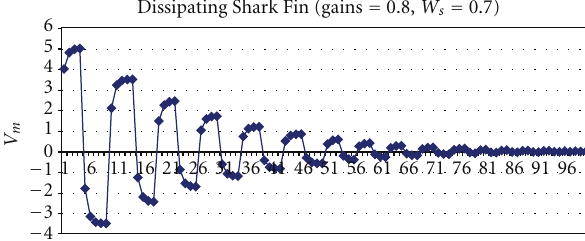
Figure 7: This figure illustrates the e ff ect of setting the interstate weights to less than 1; it creates a waveform that dissipates over time. Figure 8: This figure shows the e ff ect of setting the interstate weights to greater than 1, creating unbounded growth in the waveform, thus an unstable condition.